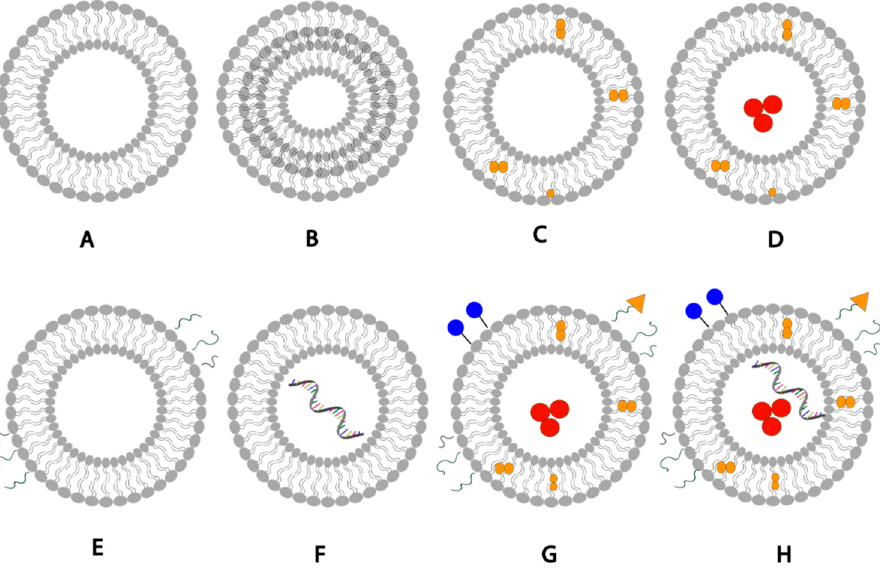
Figure 1. Schematic representation of liposomal drug delivery systems: ( A ) unilamellar liposome, ( B ) multilamellar liposome, ( C ) liposomes loaded with hydrophobic drug, ( D ) liposome loaded with hydrophobic drug in the bilayer membrane and hydrophilic drug in the aqueous core, ( E ) PEGylated liposomes with surface PEG polymer chains, ( F ) liposome loaded with mRNA, ( G ) liposome with surface conjugated drug, targeting ligands and PEG, hydrophilic and hydrophobic drugs, ( H ) liposome with surface conjugated drug, targeting ligands, PEG polymer chains, hydrophilic drug, hydrophobic drugs, and mRNA loaded. [8] [ Reuse permitted by MDPI].